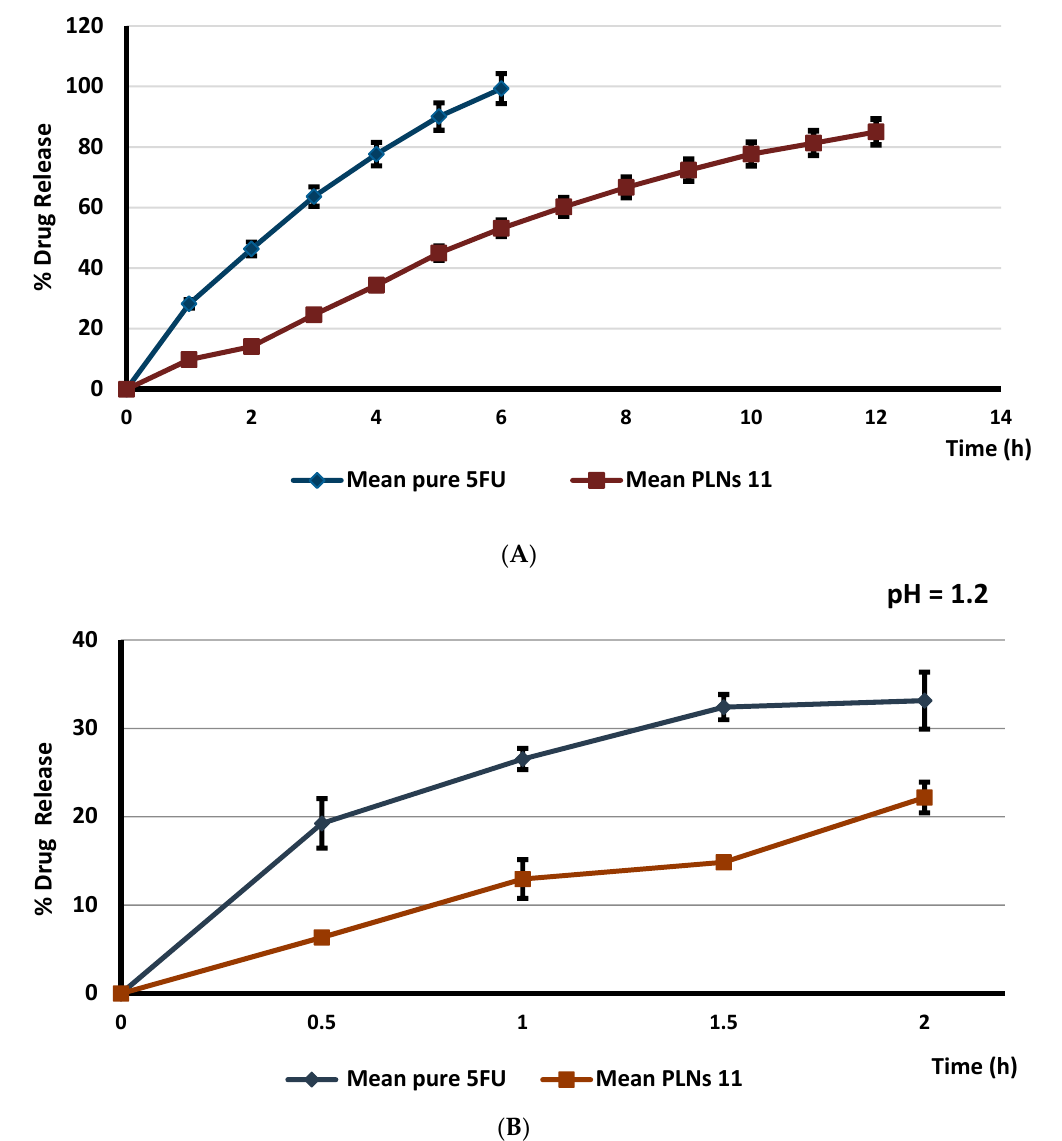
Figure 5. Release profile of 5-fluorouracil loaded on PLNs-11 at pH 6.8 (panel A ) and pH 1.2 (panel B ). Data are mean ± standard deviation for three replicates.